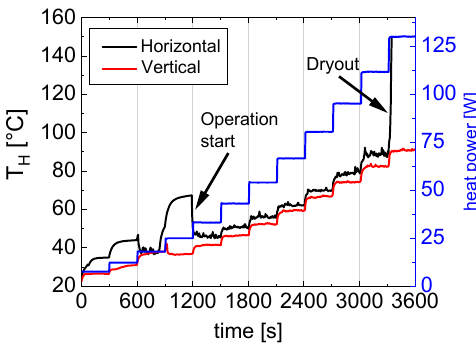
Figure 6. PHP with 1.5 × 1.5 mm 2 channels. Plot of heater temperature T H and heating power ´ Q vs. time for horizontal orientation. The PHP started operating reliably only at a heating power of 30–40